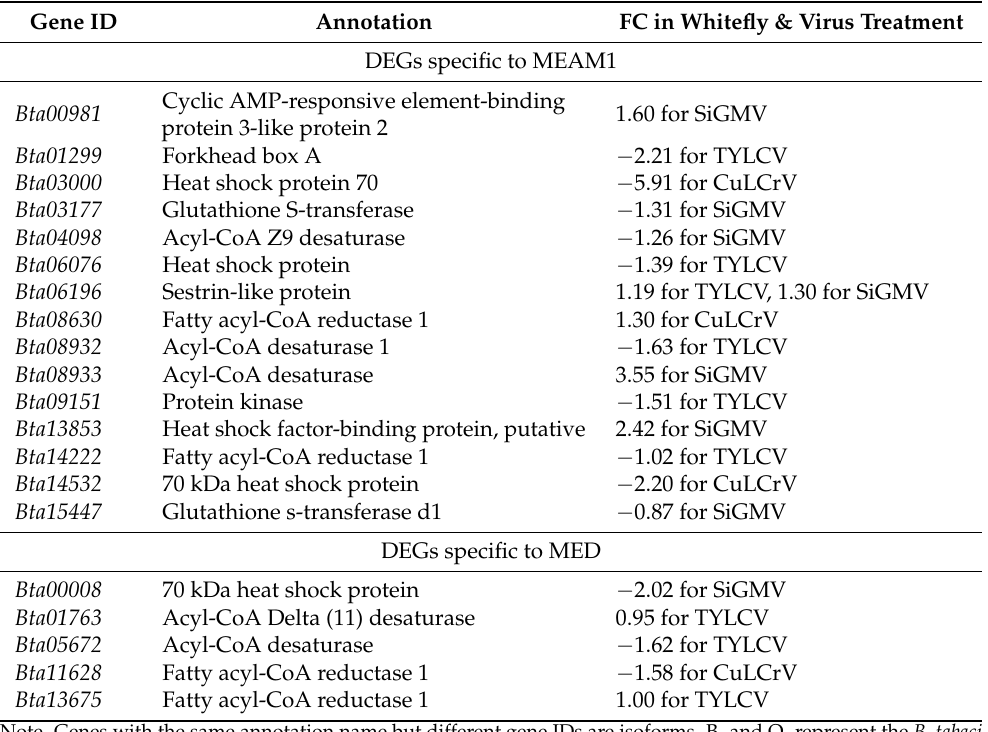
Table 6. Differential expression of genes associated with longevity in viruliferous compared with non-viruliferous Bemisia tabaci Middle East-Asia Minor 1 (MEAM1) and Mediterranean (MED) adults. Gene ID Annotation FC in Whitefly & Virus Treatment DEGs specific to MEAM1 Cyclic AMP-responsive element-binding Bta00981 1.60 for SiGMV protein 3-like protein 2 Bta01299 Forkhead box A − 2.21 for TYLCV Bta03000 Heat shock protein 70 − 5.91 for CuLCrV Bta03177 Glutathione S-transferase − 1.31 for SiGMV Bta04098 Acyl-CoA Z9 desaturase − 1.26 for SiGMV Bta06076 Heat shock protein − 1.39 for TYLCV Bta06196 Sestrin-like protein 1.19 for TYLCV, 1.30 for SiGMV Bta08630 Fatty acyl-CoA reductase 1 1.30 for CuLCrV Bta08932 Acyl-CoA desaturase 1 − 1.63 for TYLCV Bta08933 Acyl-CoA desaturase 3.55 for SiGMV Bta09151 Protein kinase − 1.51 for TYLCV Bta13853 Heat shock factor-binding protein, putative 2.42 for SiGMV Bta14222 Fatty acyl-CoA reductase 1 − 1.02 for TYLCV Bta14532 70 kDa heat shock protein − 2.20 for CuLCrV Bta15447 Glutathione s-transferase d1 − 0.87 for SiGMV DEGs specific to MED − 2.02 for SiGMV Acyl-CoA Delta (11) desaturase 0.95 for TYLCV Acyl-CoA desaturase − 1.62 for TYLCV Fatty acyl-CoA reductase 1 − 1.58 for CuLCrV Bta13675 Fatty acyl-CoA reductase 1 1.00 for